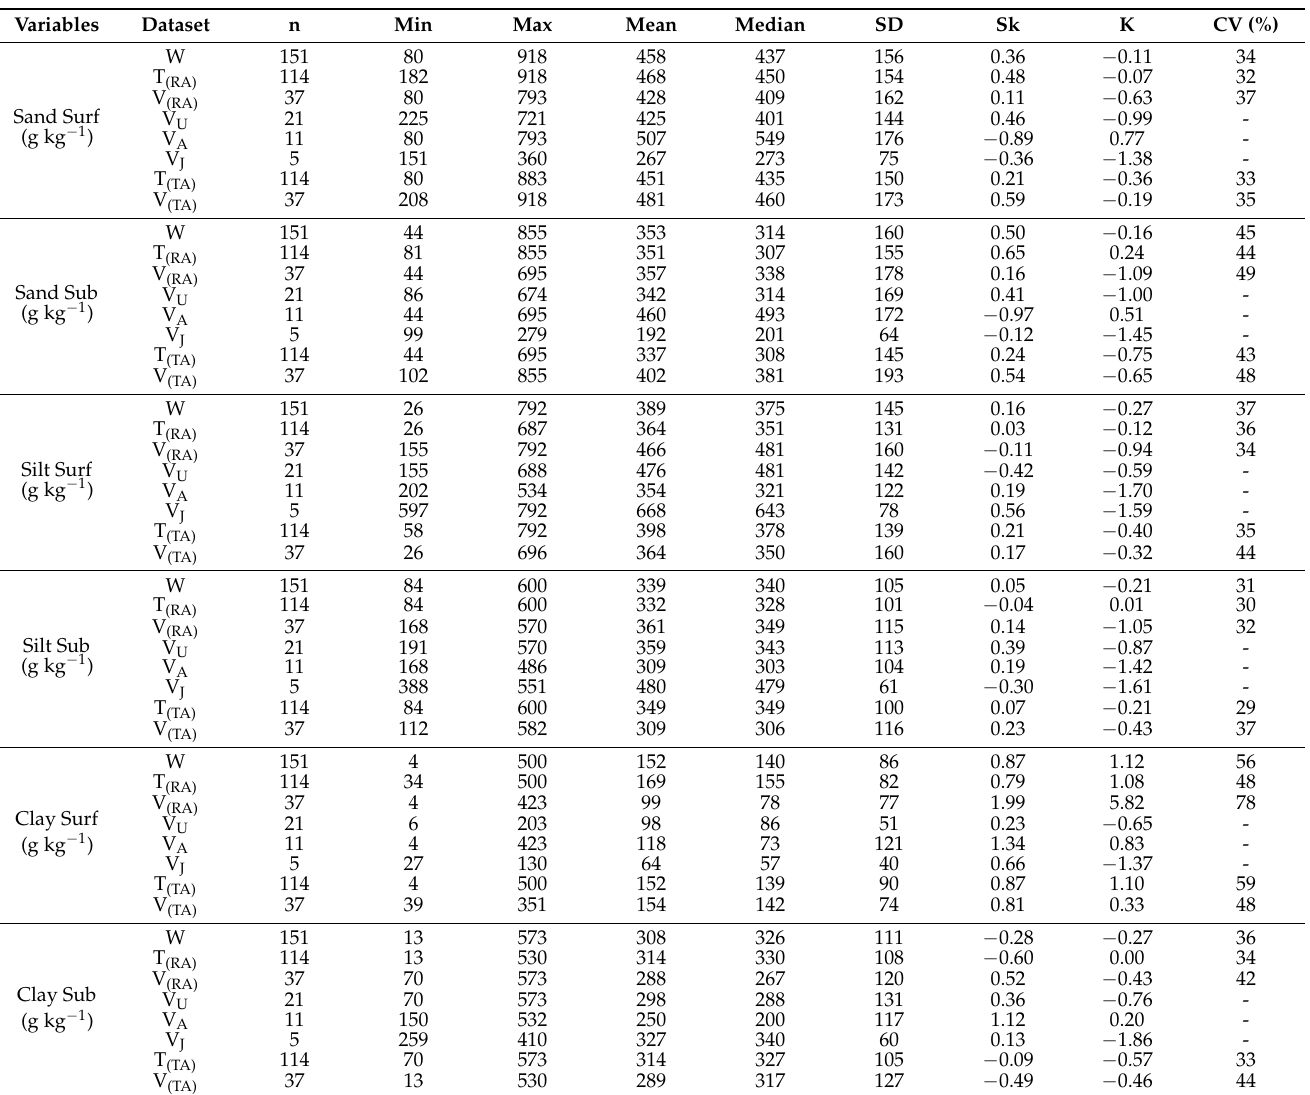
Table 3. Descriptive statistics of soil